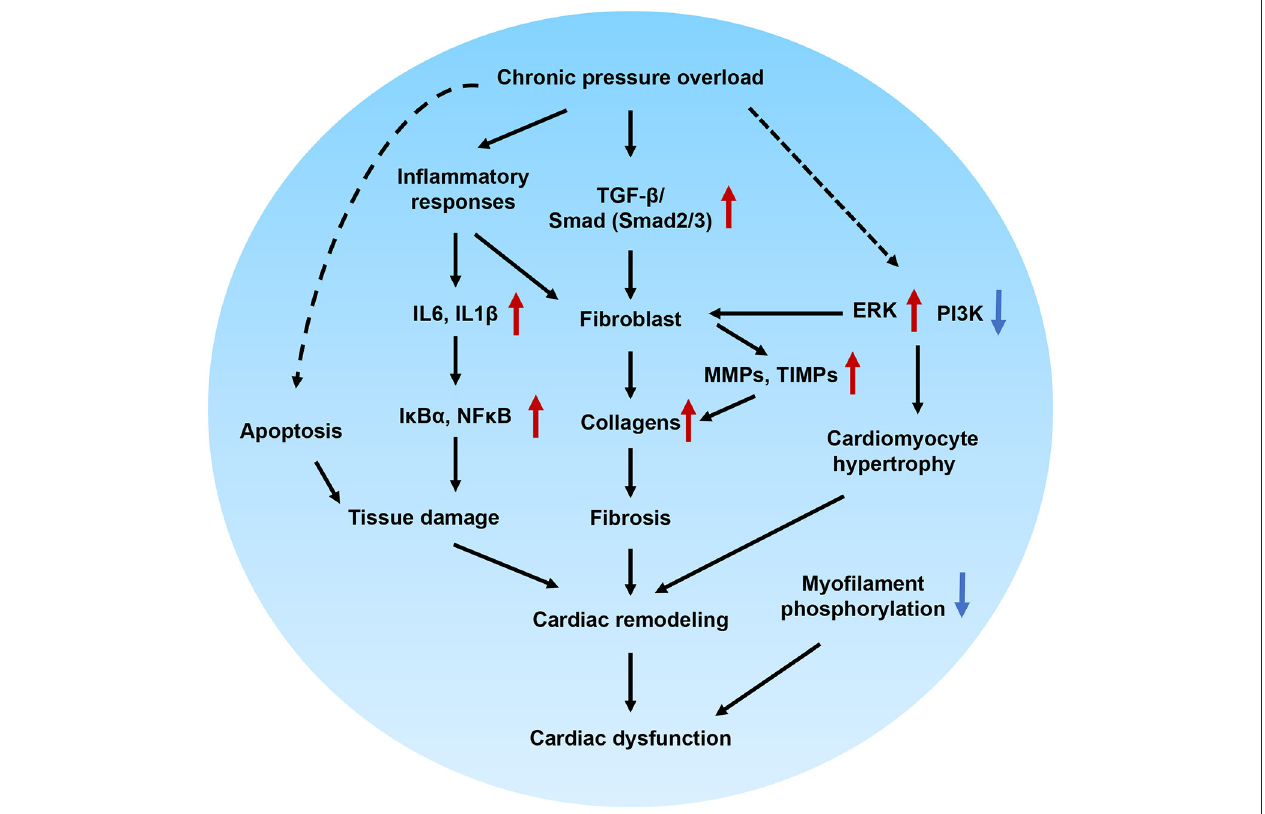
FIGURE 9 | Proposed molecular mechanisms underlying cardiac remodeling and functional impairment in HFpEF. Chronic pressure overload induces inflammatory responses, which in turn activates cytokines and intracellular NF κ B signaling and associated with tissue damage. In addition, inflammatory stimuli also involved in the fibrotic signaling. On the other hand, chronic pressure overload activates TGF- β /Smad signaling pathways, which together with inflammatory stimuli, PI3K/ERK signaling promote proliferation and differentiation of fibroblast. Furthermore, MMPs, TIMPs and several other signals regulates the production of collagens. The tissue damage, fibrosis, cardiomocyte hypertrophy, and myofilament dephosphorylation contribute to cardiac remodeling and diastolic